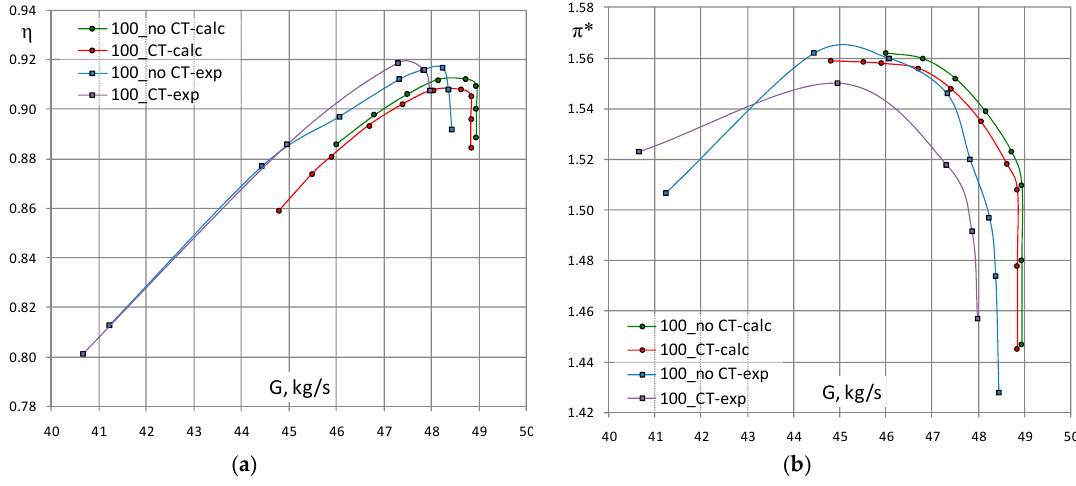
Figure 31. Integral characteristics of the CRTF2A counter rotating fan with a smooth flowpath and casing treatment. Comparison of experimental and calculated values of ( a ) adiabatic efficiency and ( b ) total pressure ratio.